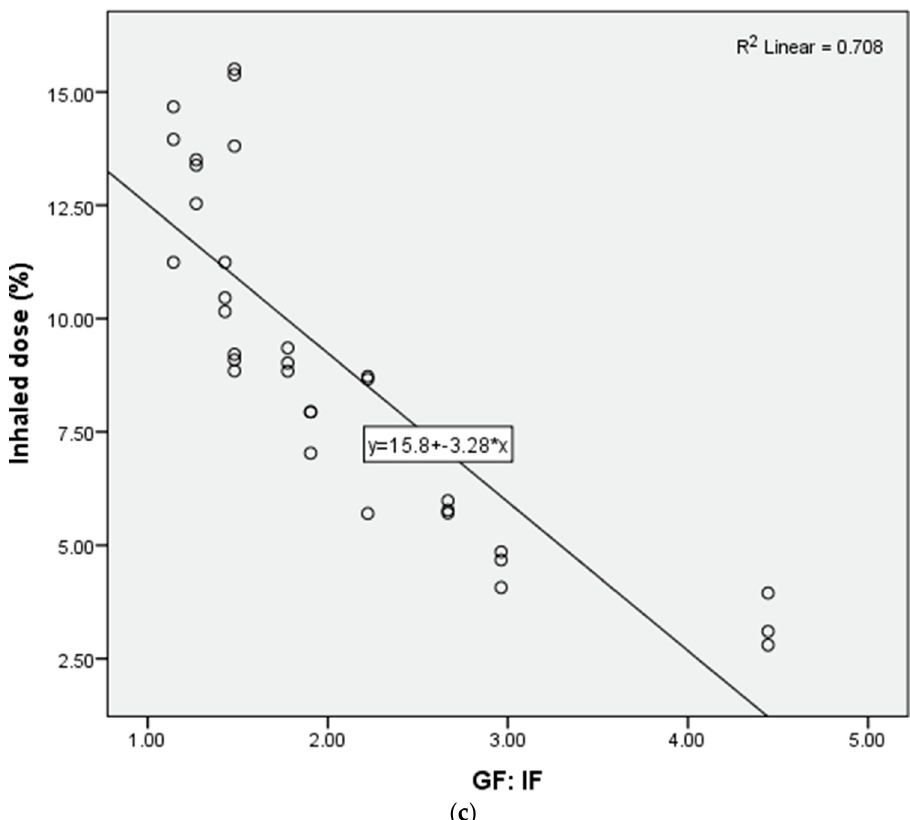
Figure 5. Scatterplot of inhaled dose and different GF: IF ratios: ( a ) 0.1–1.0; ( b ) 0.1–0.5; ( c ) 0.51–1.0.